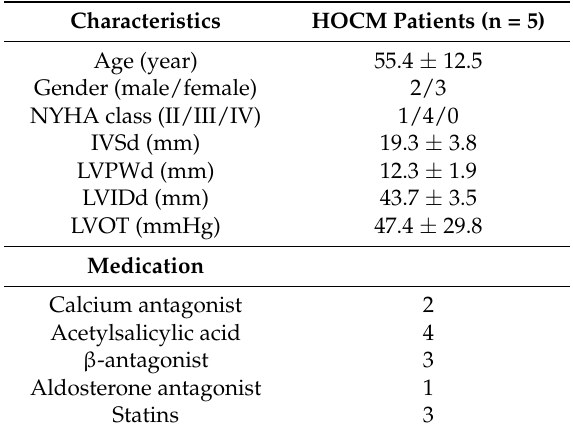
Table 1. Clinical characteristics of the patients with hypertrophic obstructive cardiomyopathy